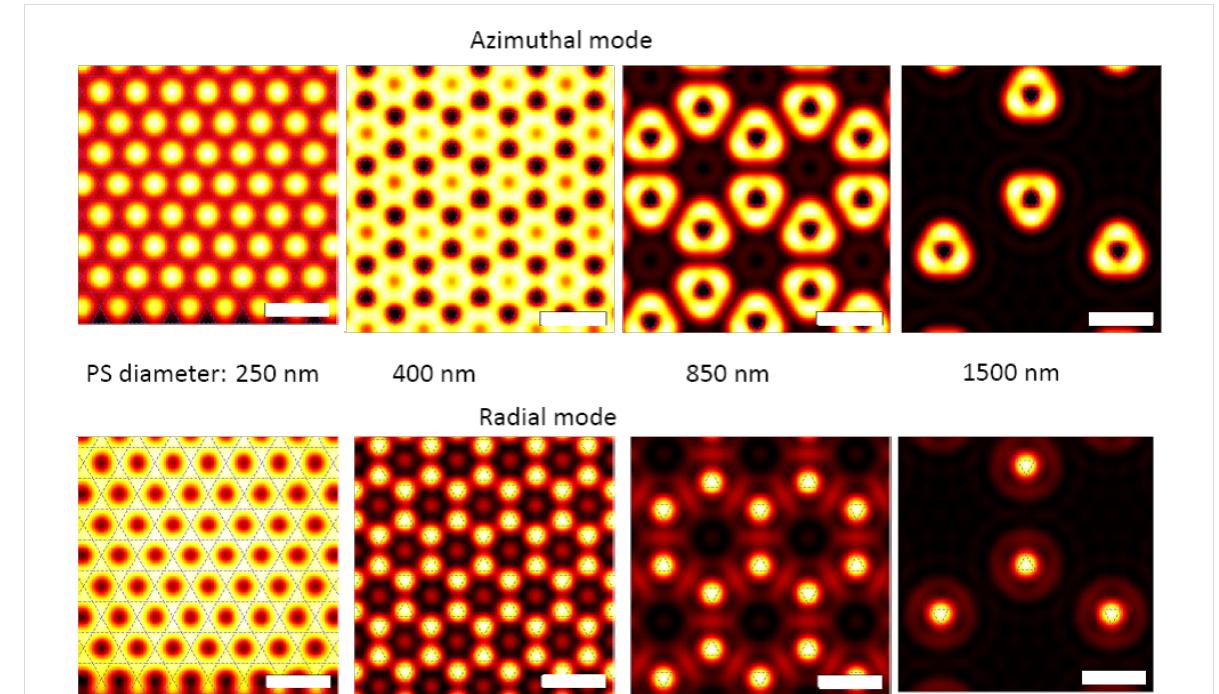
Figure 7: Calculated convolution of the intensity distribution in the azimuthal laser focus (upper row) and radial laser focus (lower row) with Fischer patterns of various sizes. The diameters of the PS spheres used for the Fischer pattern fabrication are indicated in between the two rows. The scale bars in all pictures indicate lengths of 1